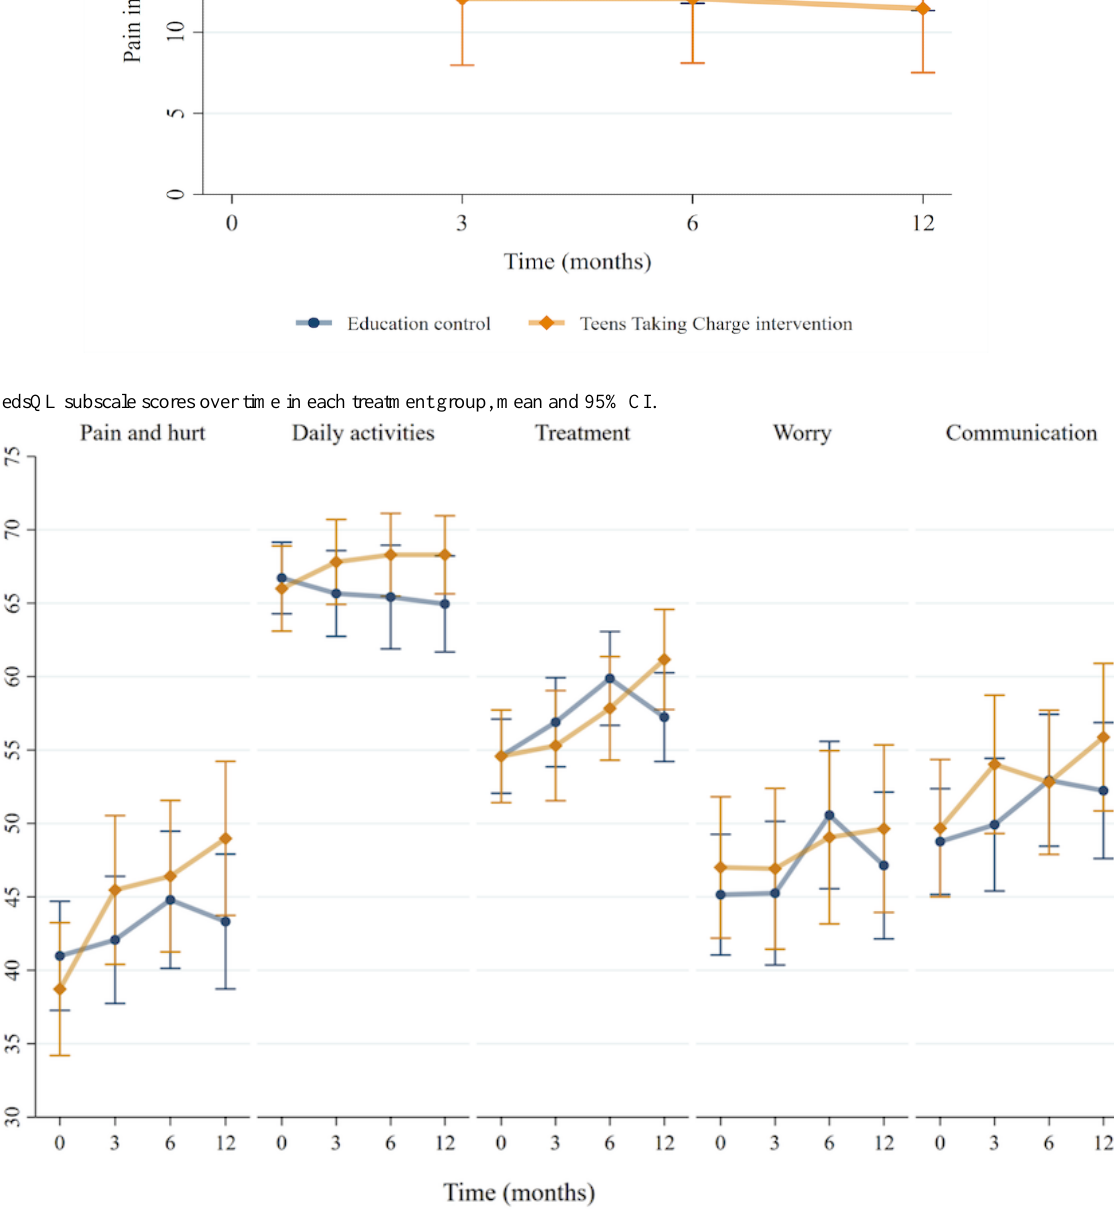
Primary and Secondary Outcomes: Caregivers The primary and secondary caregiver outcome variables as a function of condition and assessment time point are displayed